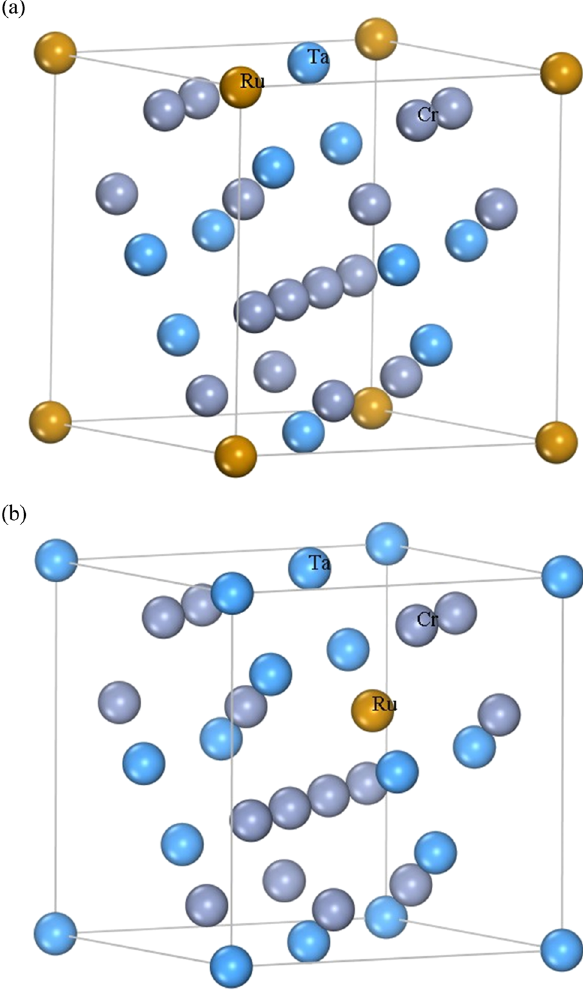
Figure 1: ( a ) Supercell model of Ta 7 RuCr 16 and ( b ) supercell model of Ta 8 Cr 15